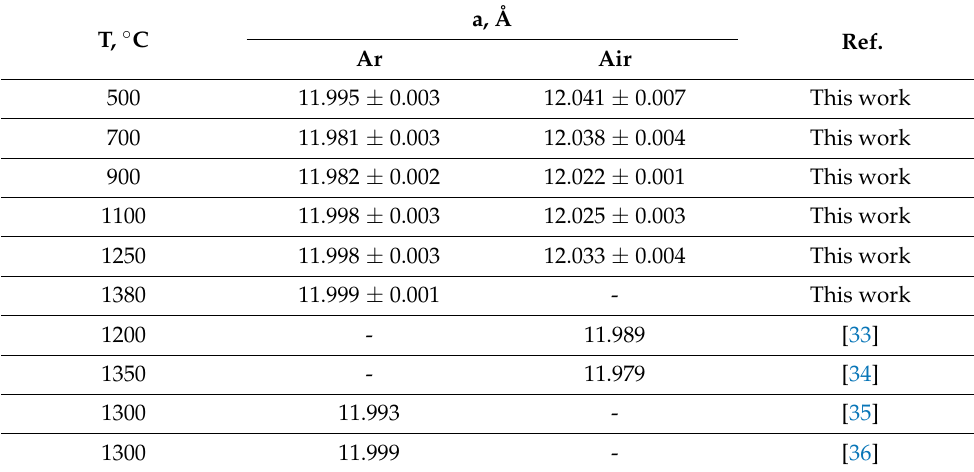
Table 1. Lattice parameters for C12A7 synthesized at different temperatures in Ar and air media.